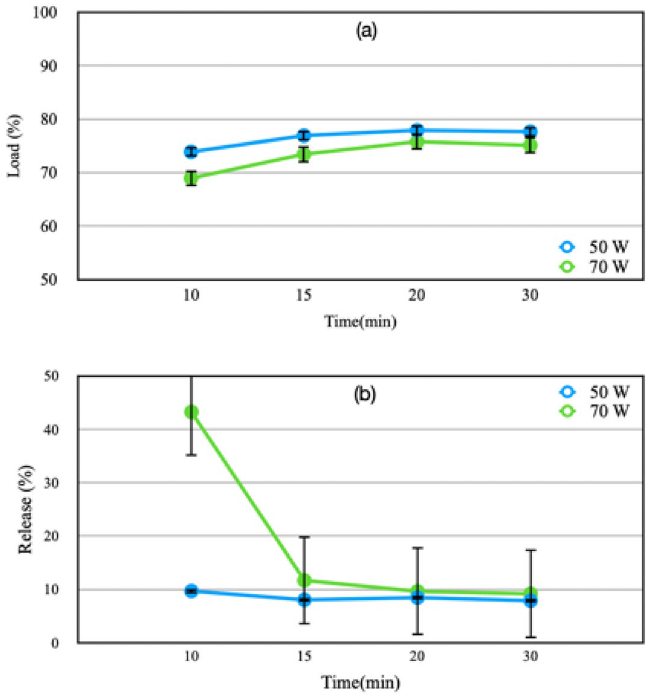
Figure 4. ( a ) BET loading percentage and ( b ) BET releasing percentage of the PP meshes as a function of F